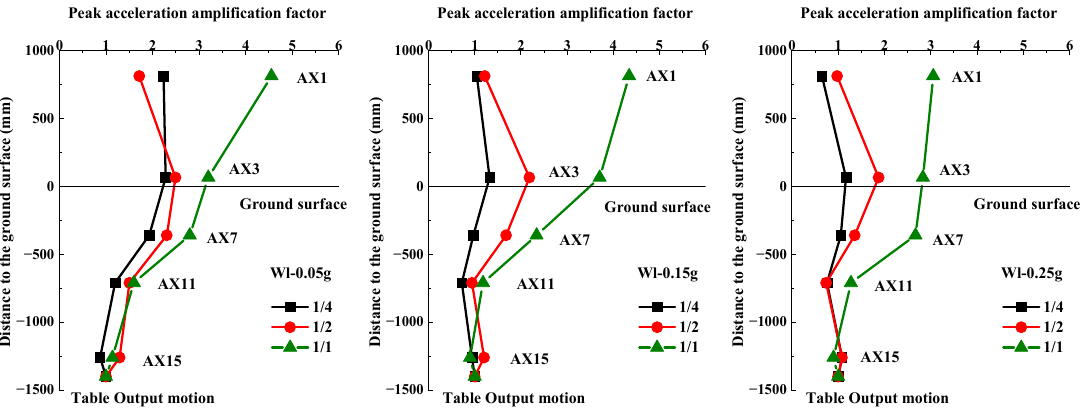
Figure 17. The peak acceleration amplification ratio of the structure under scaled Wolong records 3.5.2. Spectrum Characteristics of the Acceleration Response of the Model Structure